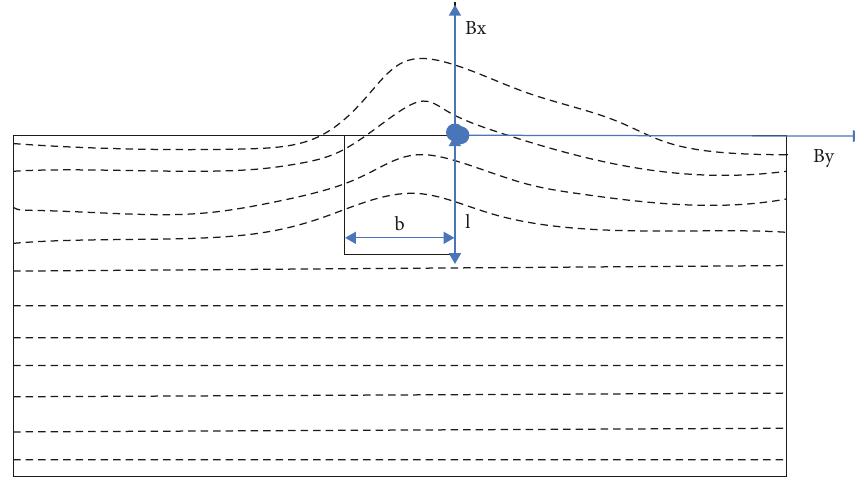
Figure 4: The characteristics of the leakage MF of the broken wire of a steel wire